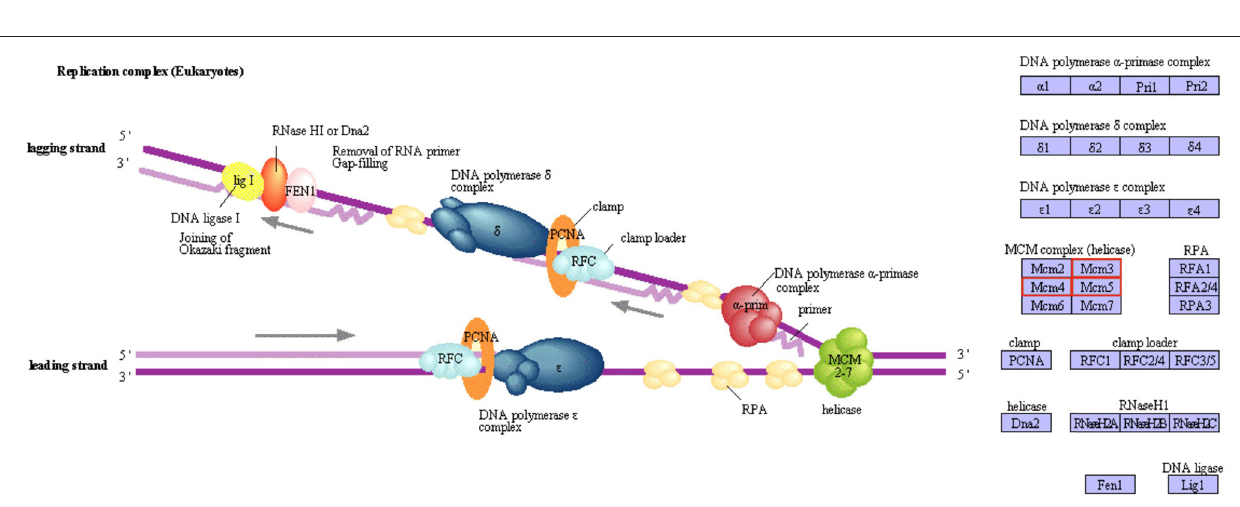
FIGURE 4 | The DNA replication pathway enriched in paralarvae fed on M diet based on KEGG pathways enrichment analysis. Upregulated genes involved in this route are marked in